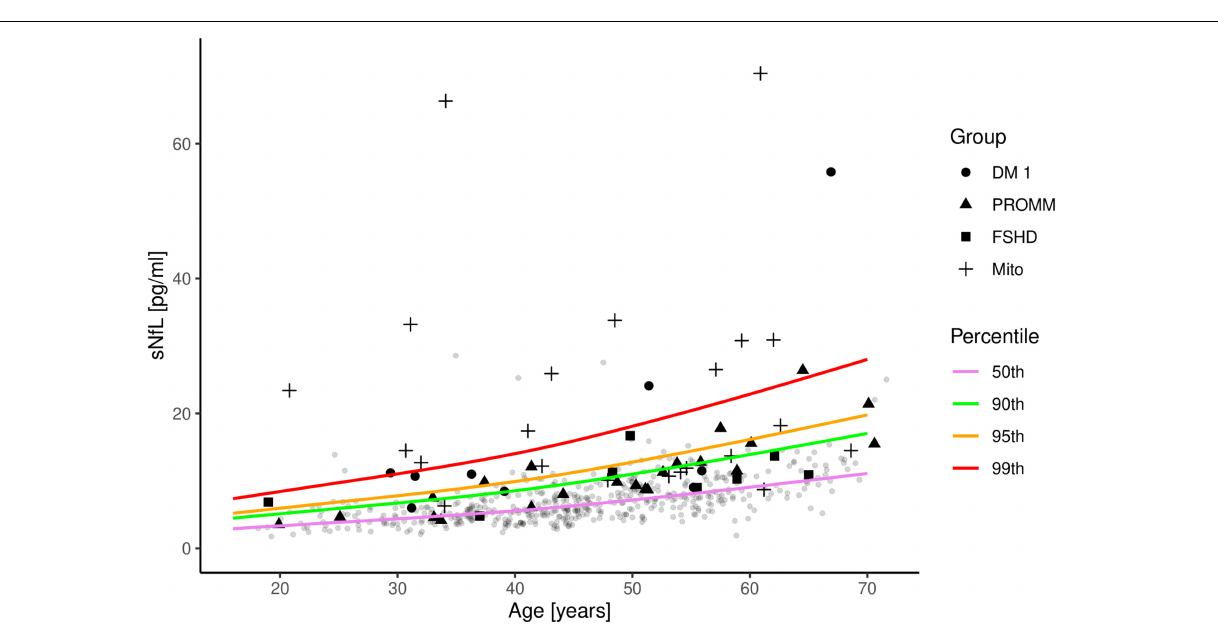
FIGURE 2 | Serum neurofilament light chain (sNfL) concentrations in the four disease groups are shown in comparison to 485 control samples. The distribution of sNfL is shown as a function of age and expressed as percentile curves (coloured lines), based on the control samples (gray circles). Patient 18 from the mitochondrial group is not included in this figure as the sNfL value is outside the range of the